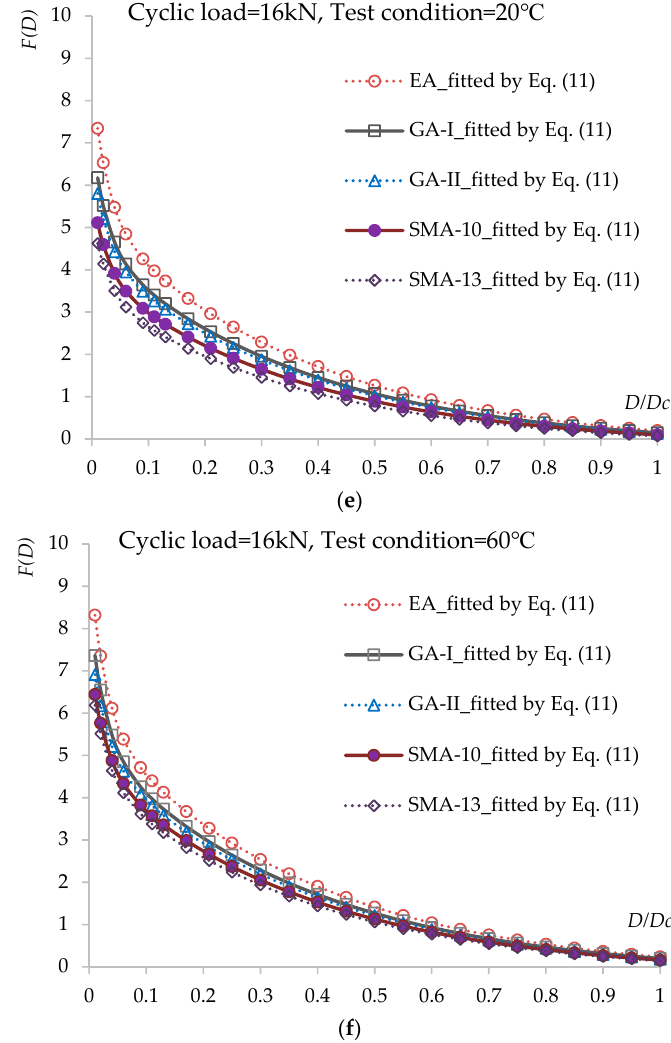
Figure 7. Relationship between accumulated energy F ( D ) and damage evolution D = D i / D C under different loading cycle levels and test conditions: ( a ) cyclic load = 12 kN, test condition = − 15 °C; ( b ) cyclic load = 12 kN, test condition = 20 °C; ( c ) cyclic load = 12 kN, test condition = 60 °C; ( d ) cyclic load = 16 kN, test condition = − 15 °C; ( e ) cyclic load = 16 kN, test condition = 20 °C; ( f ) cyclic load = 16 kN, test condition = 60 °C.